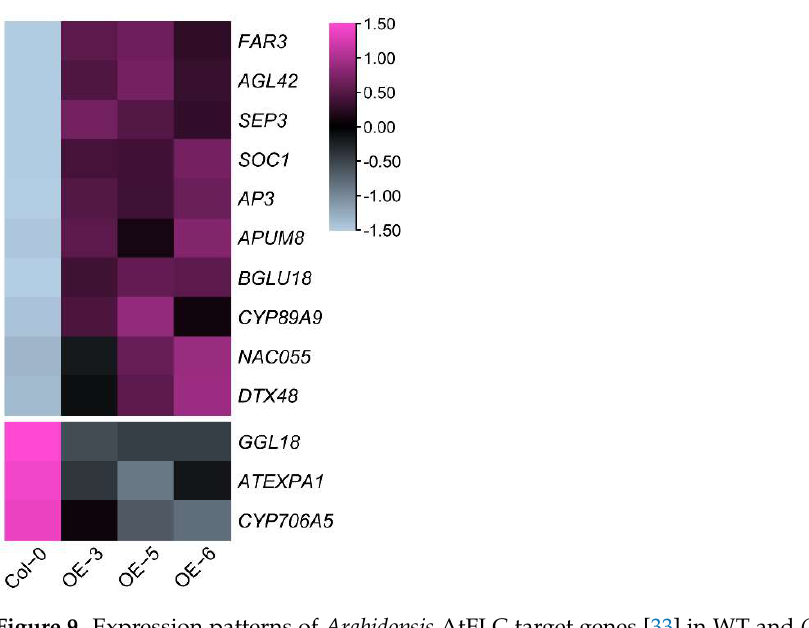
Figure 8. Expression of genes related to phytohormones in WT and OE-CsFLC1 lines. ( A ) Expression of genes related to auxin in WT and OE-CsFLC1 lines. ( B ) Expression of genes related to SA in WT and OE-CsFLC1 lines. ( C ) Expression of genes related to JA in WT and OE-CsFLC1 lines. ( D ) Expression of genes related to ABA in WT and OE-CsFLC1 lines. IAA: indole-acetic acid; SA: salicylic acid; JA: jasmonic acid; ABA: abscisic acid. Different letters (a, b and c) on the column indicate significant difference between the data ( p < 0.05).